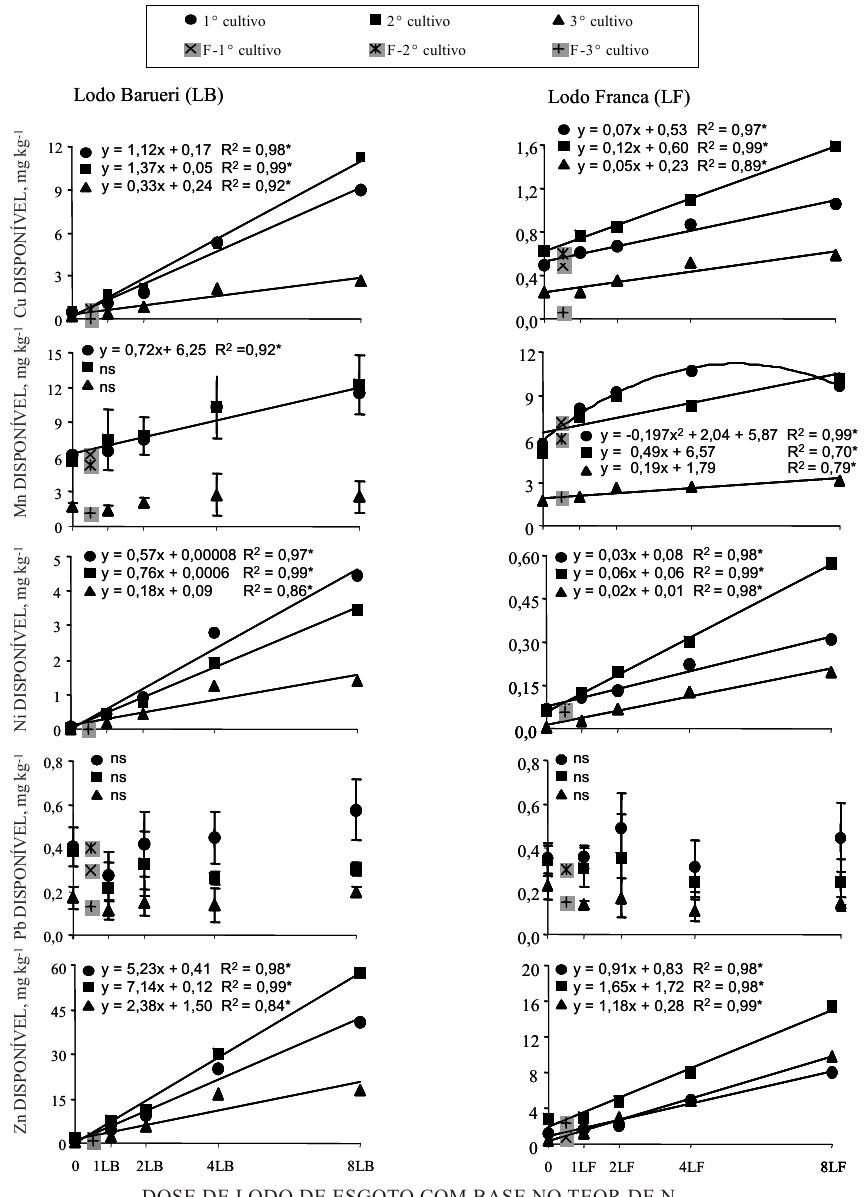
DOSE DE LODO DE ESGOTO COM BASE NO TEOR DE N